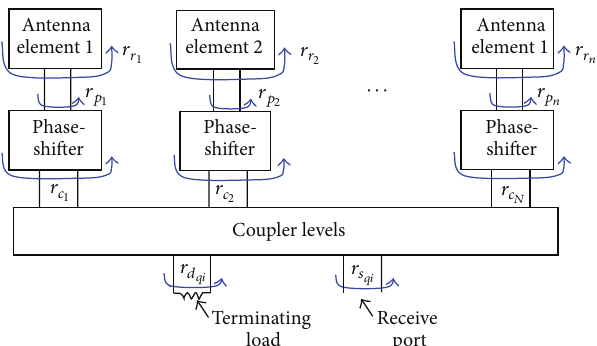
Figure 10: Reflection coefficients at different levels of the parallel feed network.